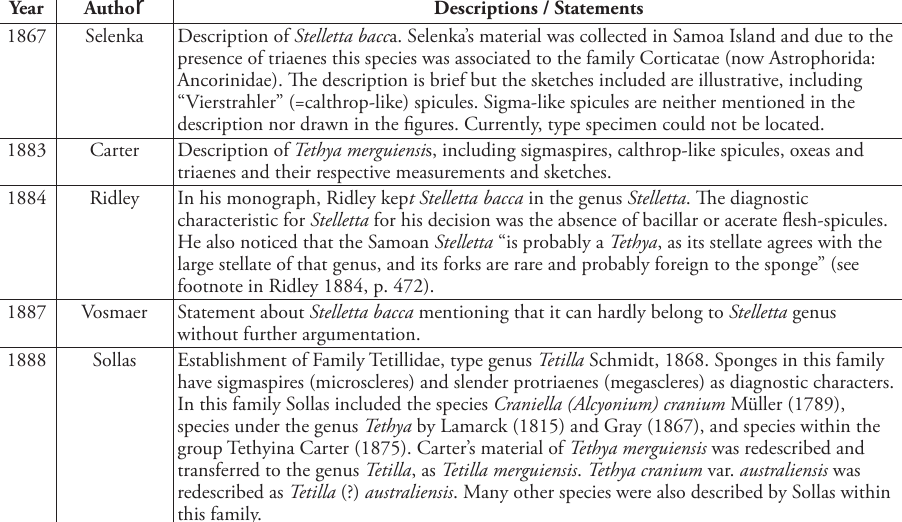
Table 3. Historic milestones in the taxonomy of the genus Paratetilla Dendy, 1905. Asterisk (*) indicates misidentification of Cinachyrella specimens as Paratetilla